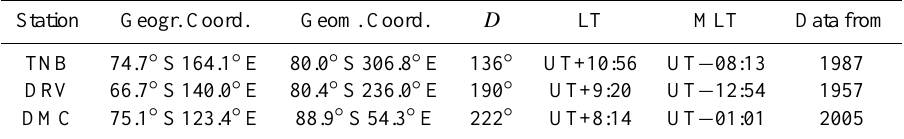
Table 1. Geographic and corrected geomagnetic (IGRF06) coordinates, declination D (average value from the 2006 experimental data), geographic local time (LT) and corrected geomagnetic local time (MLT) of the three stations TNB, DRV and DMC; the last column reports the year from which data are available.